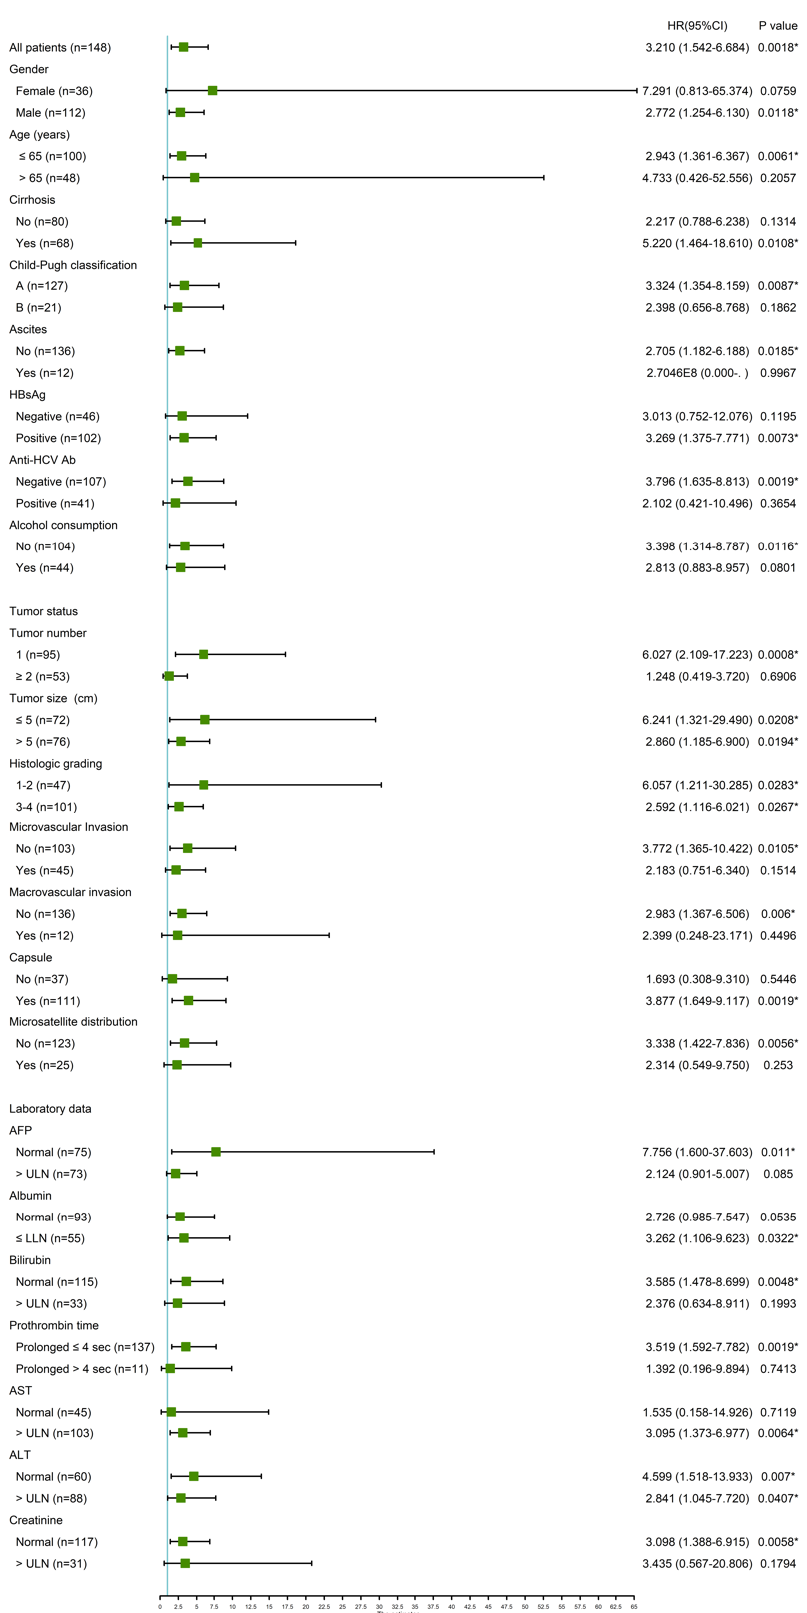
Figure 2. Forest plot of HRs for the associations between high AXNA2 expression and OS in various clinical subgroups. The subgroup-specific HR (95% CI) is shown by the green box (black lines). Statistically significant differences ( p < 0.05) are indicated by a single asterisk ”*”.